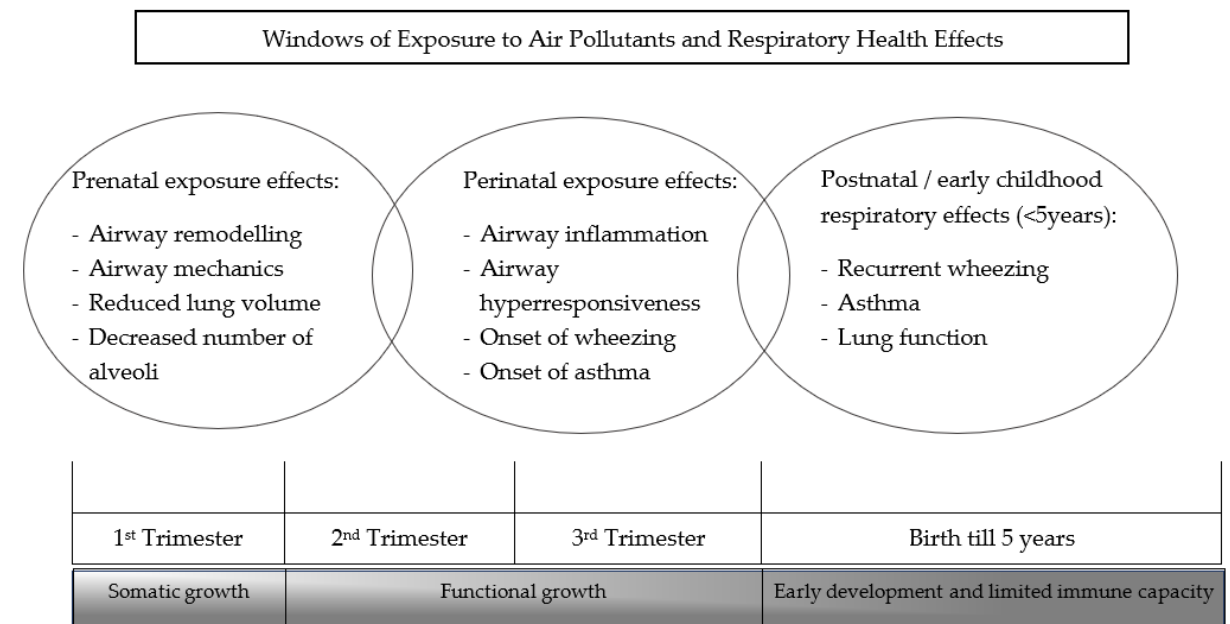
Figure 1. Summary of respiratory health effects of air pollution by exposure windows by exposure windows showing prenatal [4,5], perinatal [6,28] and postnatal/early childhood respiratory effects [3,7].